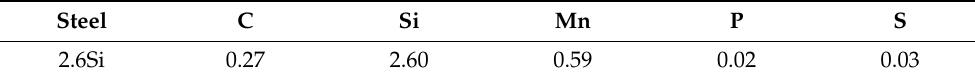
Table 1. Chemical composition of silicon-alloyed steel.